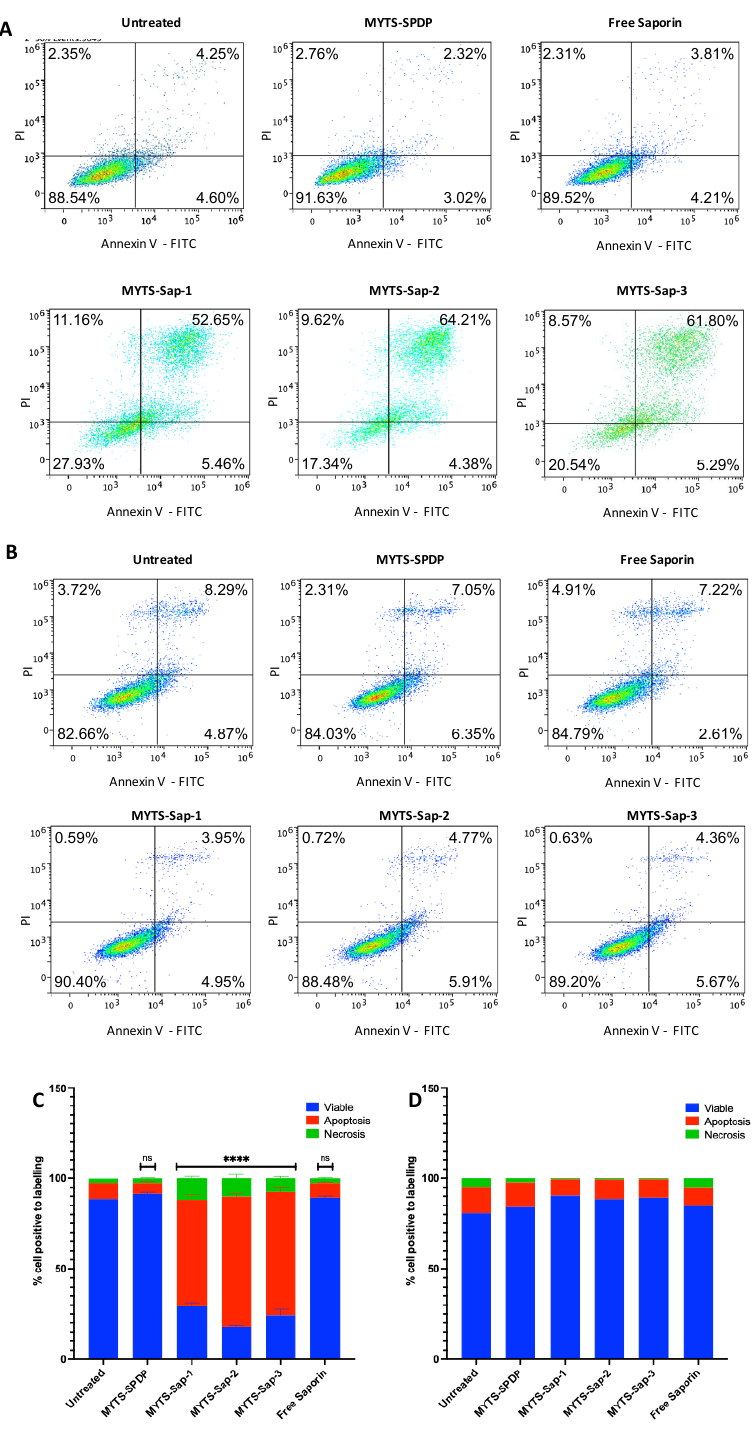
Figure 4. Annexin-V-FITC/PI double staining assay for the detection of apoptosis and/or necrosis performed on ( A , C ) SK-BR-3 cells and ( B , D ) NIH-3T3 cells, following 24 h of incubation with MYTS- SPDP, MYTS-Sap-1, MYTS-Sap-2 and MYTS-Sap-3 at concentrations of 75 µg/mL and free Saporin at the equivalent highest concentration found in the MYTS-treated samples (MYTS-Sap-3, approximately 166.6 nM). Viable: lower left quadrant; Apoptosis: lower + upper right quadrants; Necrosis: upper left quadrant. **** p < 0.0001; ns = non-significant vs. untreated.